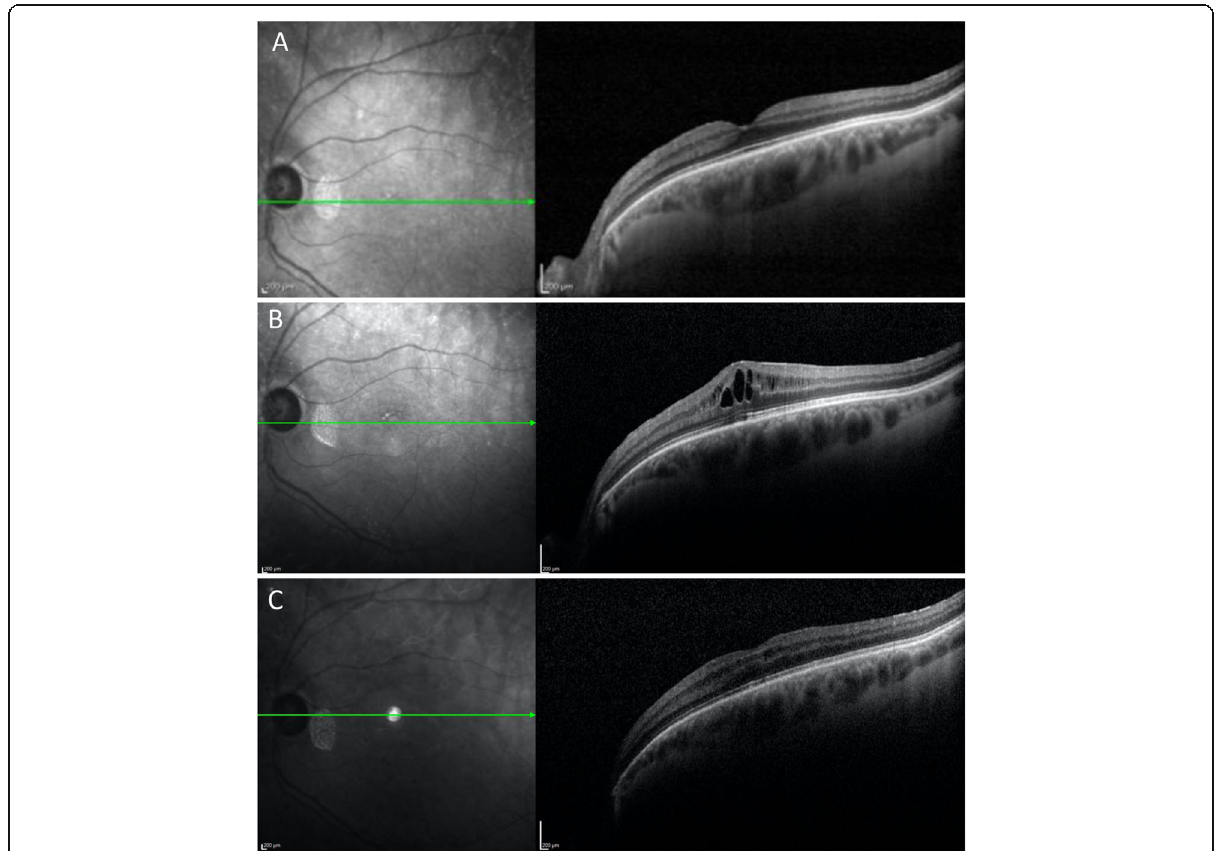
Fig. 1 A 58 yo female with a 9 month history of fingolimod developed macular edema in her left eye. She responded to bromfenac topical drops used twice daily although she continued fingolimod. Normal macular contour is demonstrated on OCT at the initial screening visit ( a ) OCT demonstrates FAME at the 9 month follow up visit ( b ) OCT after 6 weeks shows reduction in the edema ( c